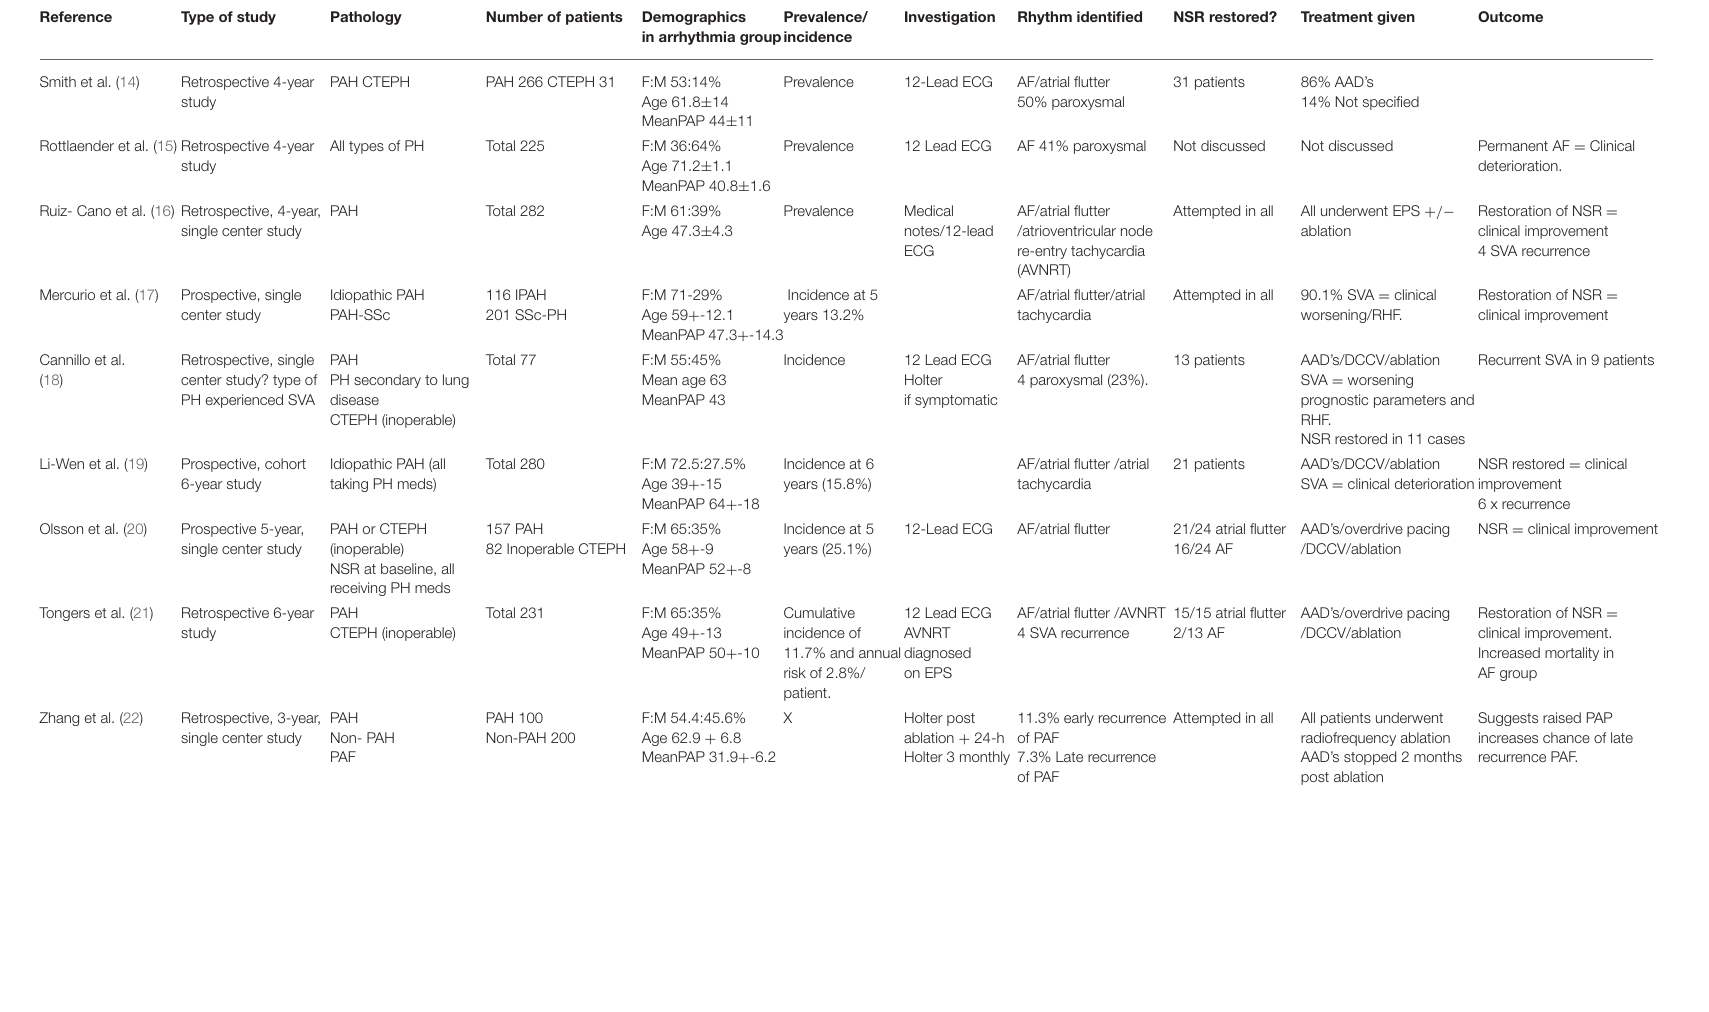
TABLE 1 | Summary of literature reviewing SVA in